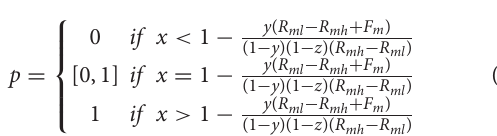
TABLE 5 | Simulation numerical